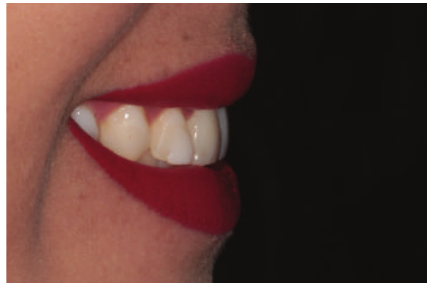
Figure 1: Initial smile of this patient.